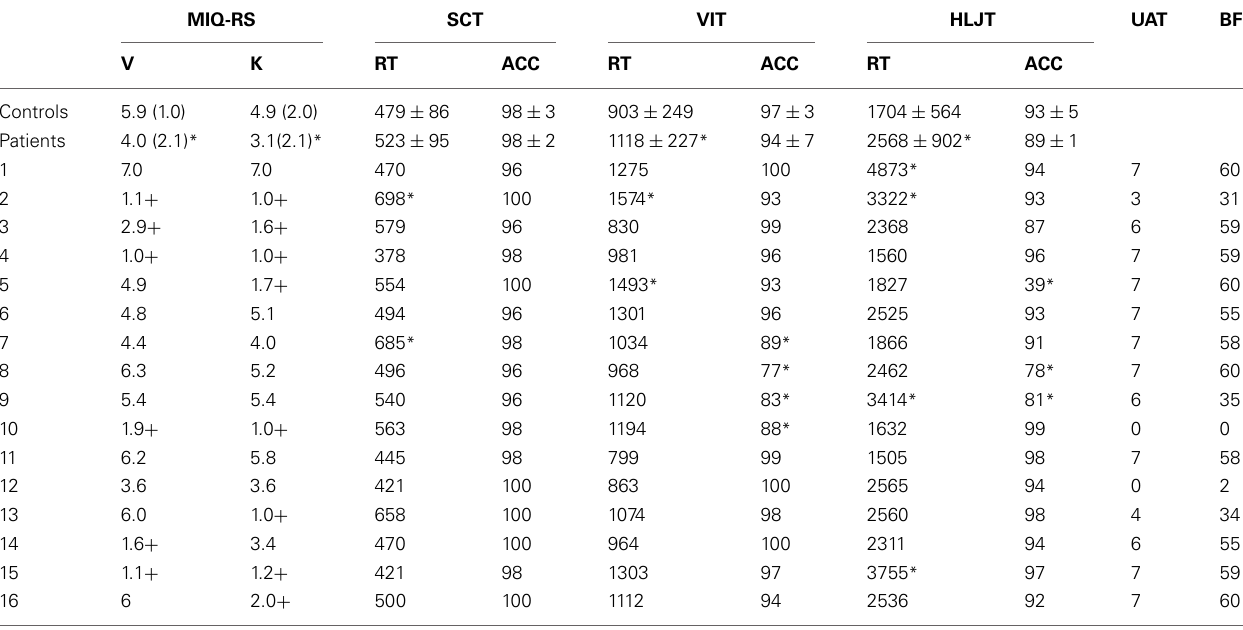
Table 1 | Scores (mean/ SD ) on the MIQ-RS and hand laterality task, the object identification task and the visual imagery task for the group of controls and patients and the individual patient scores for the UAT and BFM ( N =